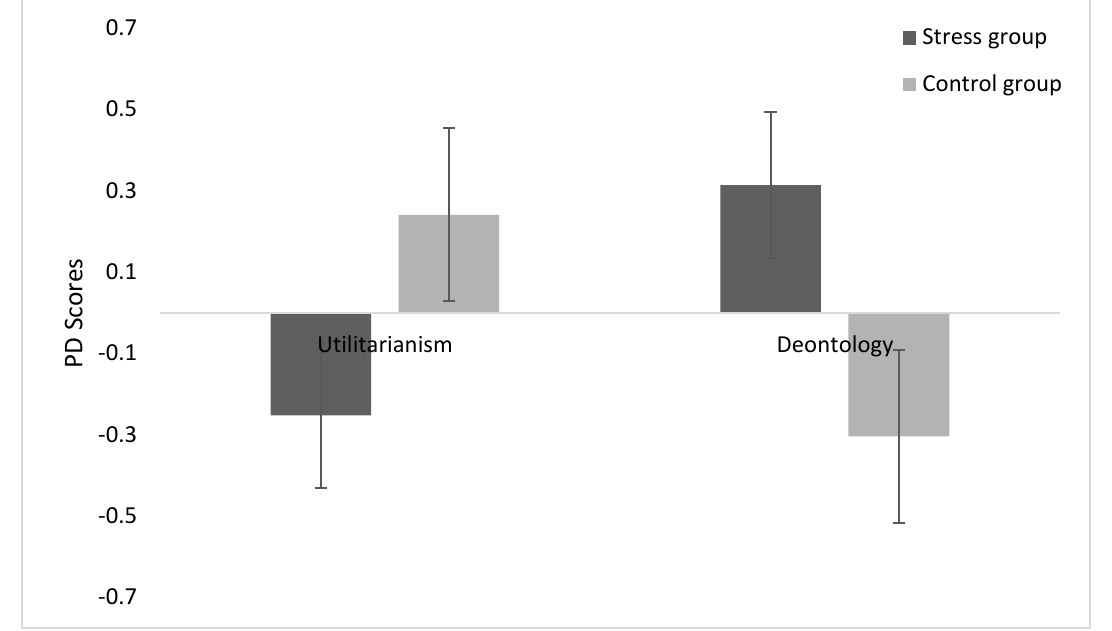
Figure 2. Mean standardized process-dissociation (PD) scores for the Stress and Control groups. Error bars represent standard errors of the mean. Table 2. Stress, emotional response, and moral judgment using the PD approach.